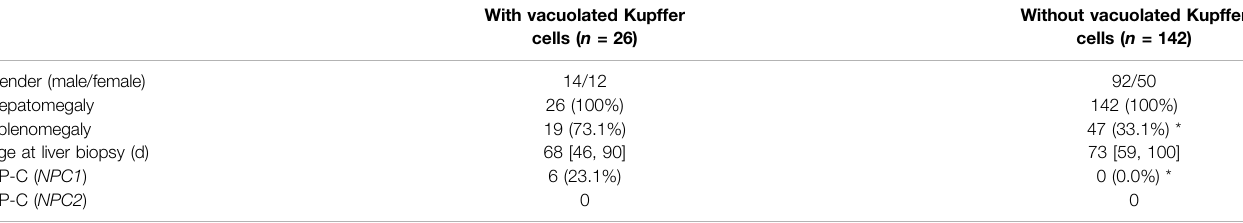
NP-C, Niemann-Pick disease type C. Interquartile range in square